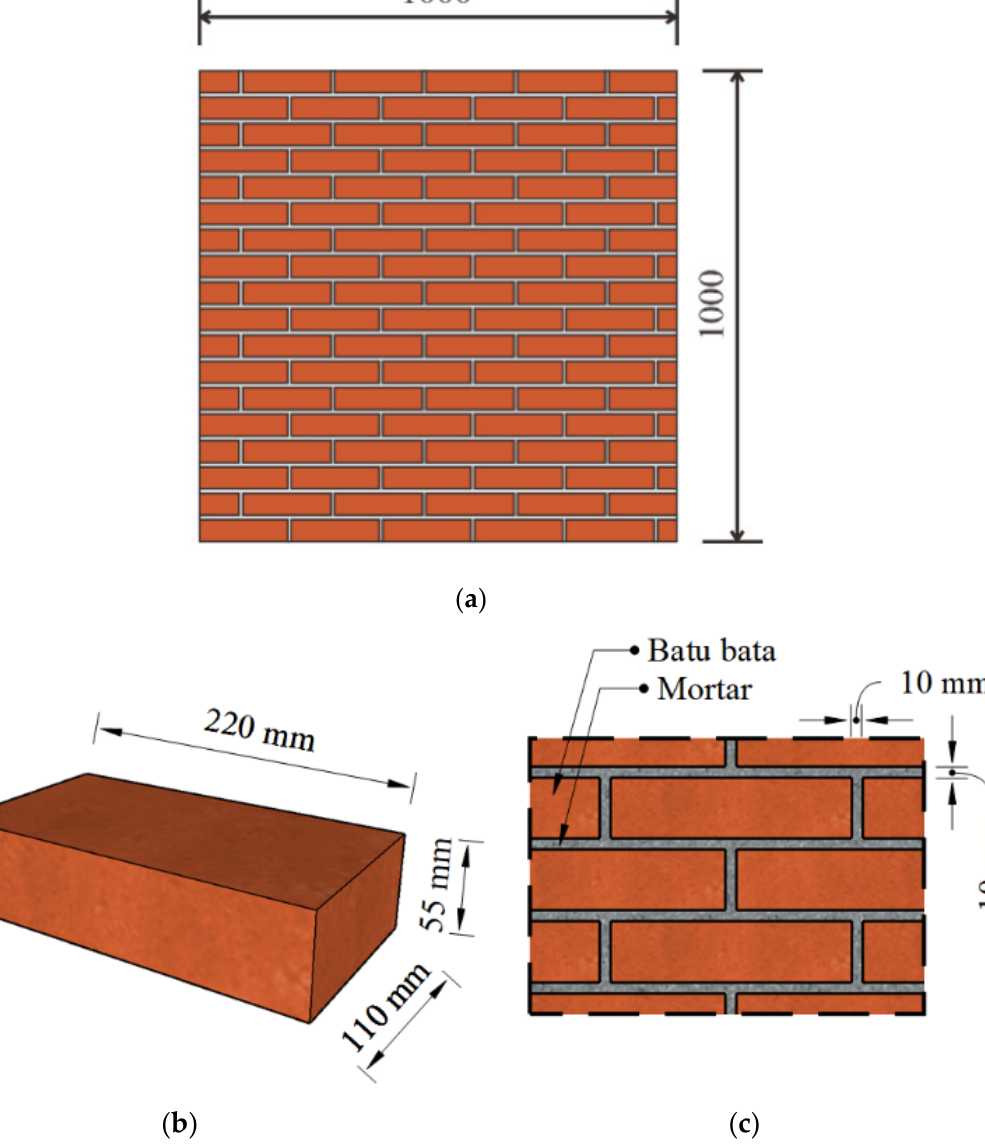
Figure 8. ( a ) The dimension of the masonry panel for the diagonal compressive test, ( b ) the dimension of the brick unit, and ( c ) the thickness of the mortar joint.